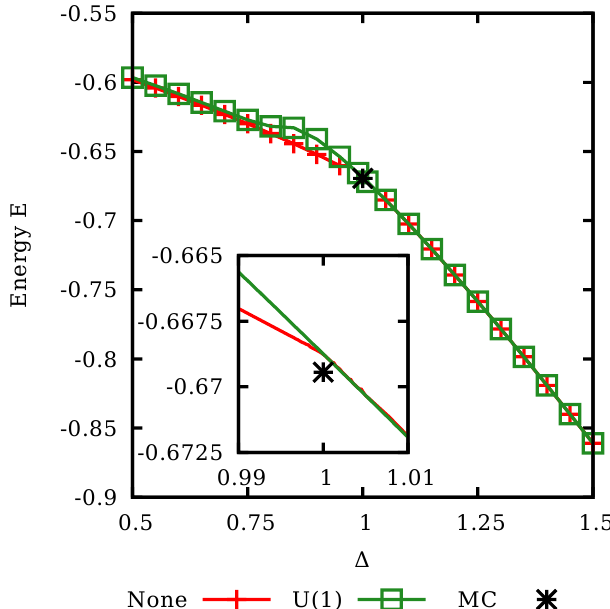
Figure 7: As left, for D = 4. At small enough ∆ , the U ( 1 ) symmetric state becomes competitive again but still has slightly higher energy than the unconstrained state. Monte Carlo reference value at ∆ = 1 taken from Ref. [ 47 ] . Error bars are smaller than symbol size in all